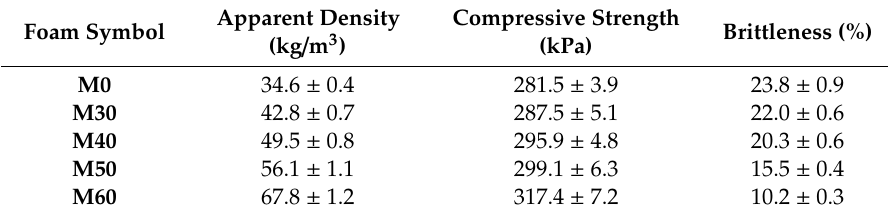
Table 5. Values of apparent density, compressive strength and brittleness of obtained RPU/PIR foams.